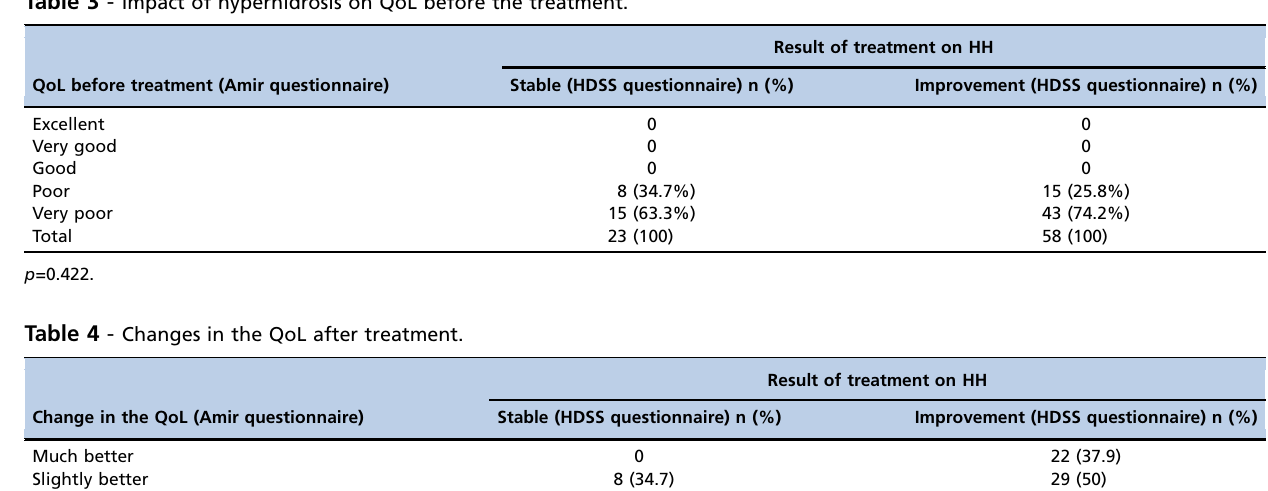
Table 3 - Impact of hyperhidrosis on QoL before the treatment. QoL before treatment (Amir questionnaire)